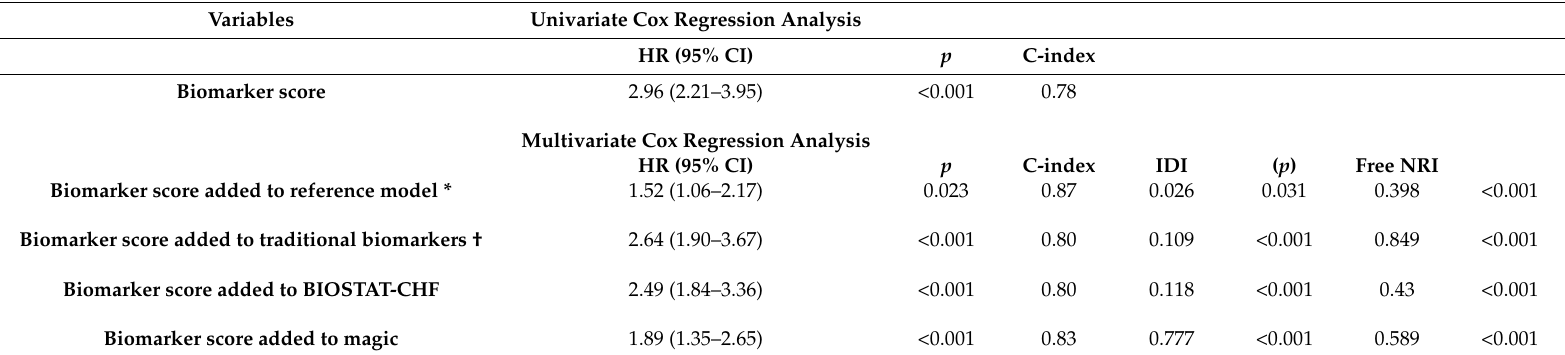
Table 4. Predictive value of the score based on the presence and the number of high NT-proBNP, galectin-3, or ST2 serum